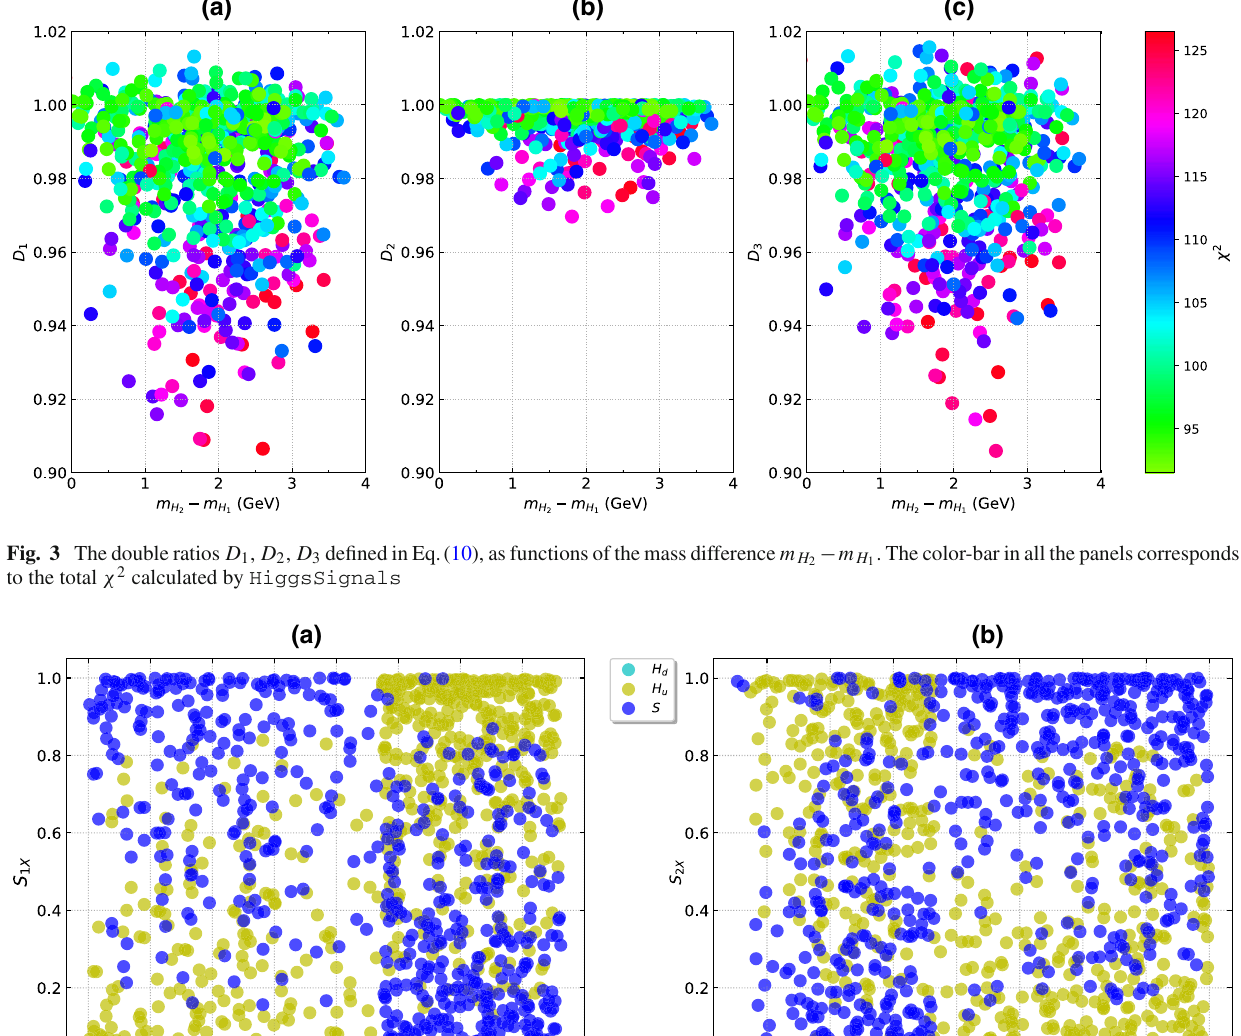
Fig. 4 The field components of H 1 ( H 2 ) versus m H ( m H ). The samples with dark blue color represent the component of singlet field S 3 , the 1 2 samples with yellow color represent the component of field S 2 , and the samples with light blue color represent the component of field S 1 ( W W )/ R h ( W W R h gg VBF D 3 =